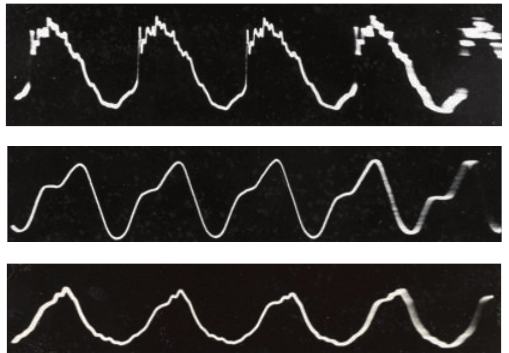
Figure 9: Typical pressure oscillograms in steady rotating DW in different points of circle channel (special piezogauges with thermoi- solation from hot products